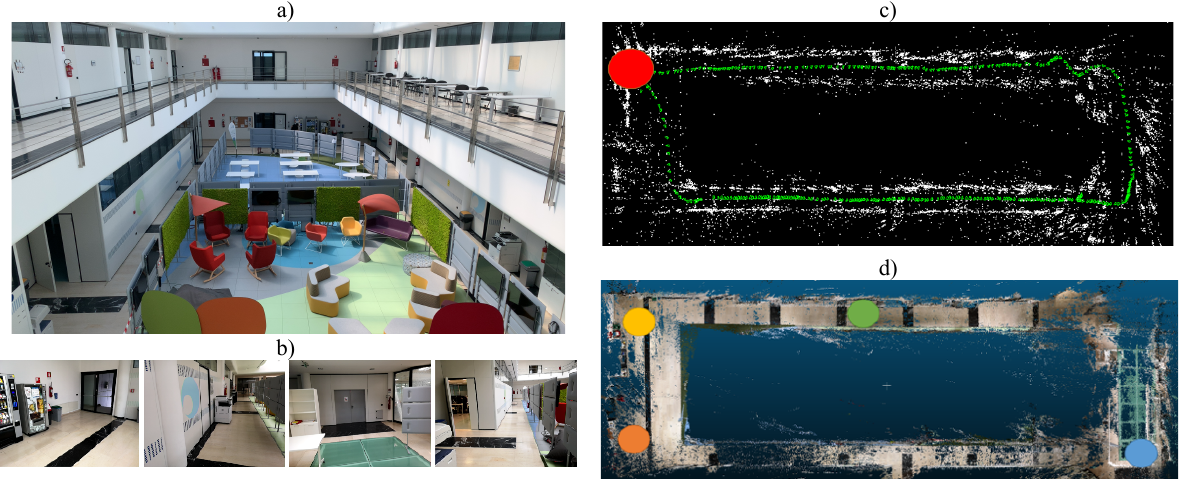
Figure 3 . The area for the accuracy test (a) and some images of the scene (b). The obtained camera poses and sparse reconstruction of the area (c). The generated dense point cloud used to position the virtual elements (c) with colored dots showing locations of virtual objects (Fig. 4a,